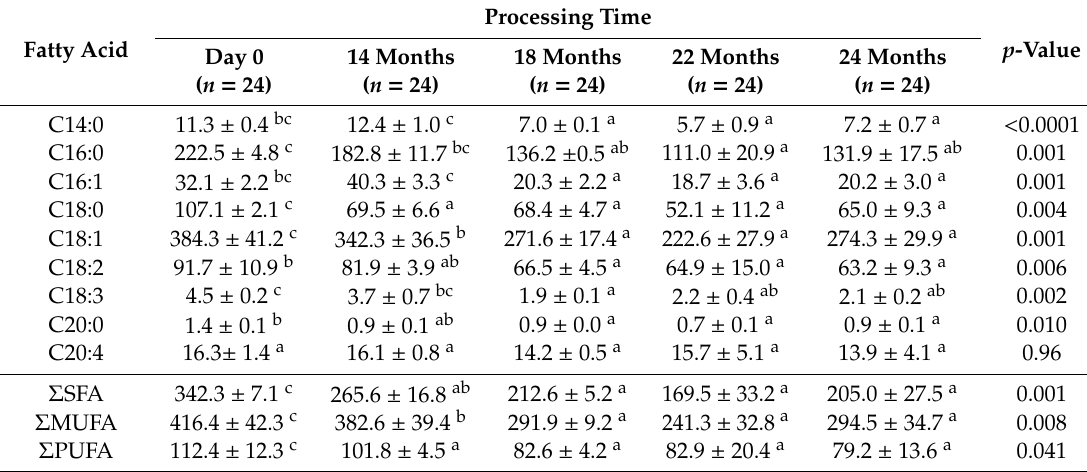
Table 2. E ff ect of processing time on fatty acids contents of neutral lipids in Chato murciano